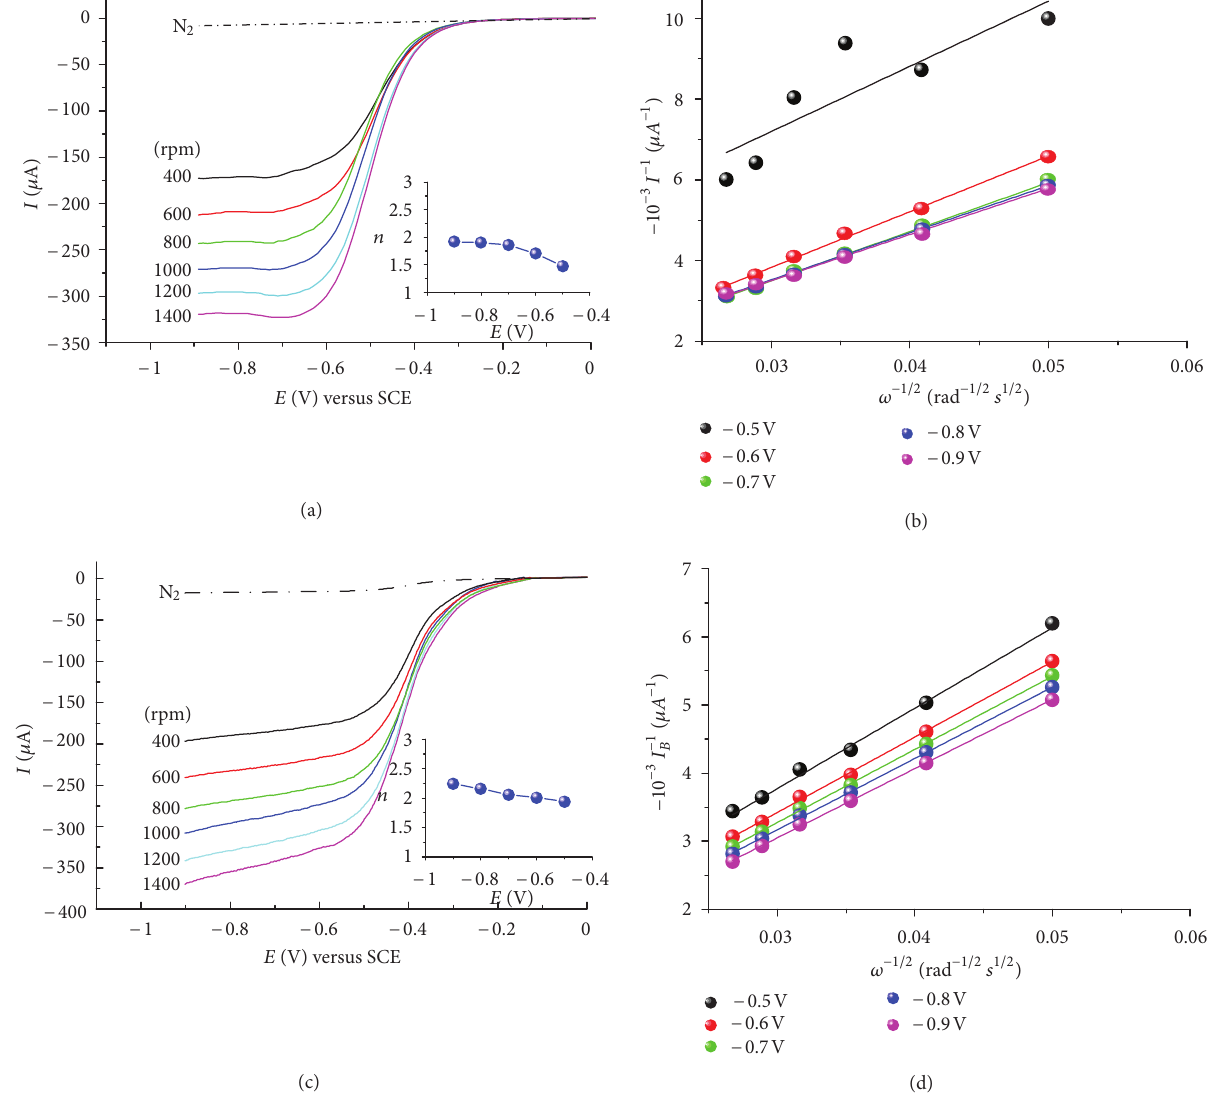
F 7: RDE voltammetry curves of oxygen reduction on (a) MHAQ/GC and (c) MHAQ/MWCNTs/GC electrodes in pH 7.0 O . e Koutecky-Levich plots of oxygen reduction on (b) MHAQ/GC and saturated solutions at various rotation rates. Scan rate: 10mVs (d) MHAQ/MWCNTs/GC electrodes at various cathodic potentials. e insets in (a) and (c) show the potential dependence of the number −1 molecule. of electrons transferred per O 2